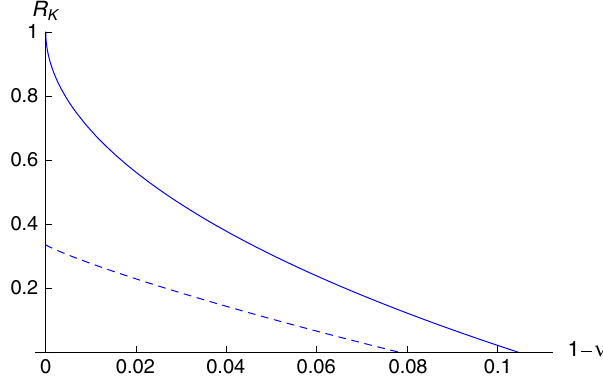
FIG. 1. Asymptotic secret key rate R vs noise 1 (cid:3) (cid:7) for the K ¼ (cid:7) j (cid:8) ih (cid:8) j þ ð 1 (cid:3) (cid:7) Þ 1 = 4 , where CHSH protocol and a state (cid:4) (cid:7) j (cid:8) i is maximally entangled. The upper curve corresponds to a quantum adversary, while the lower one considers an adversary only limited by the no-signaling